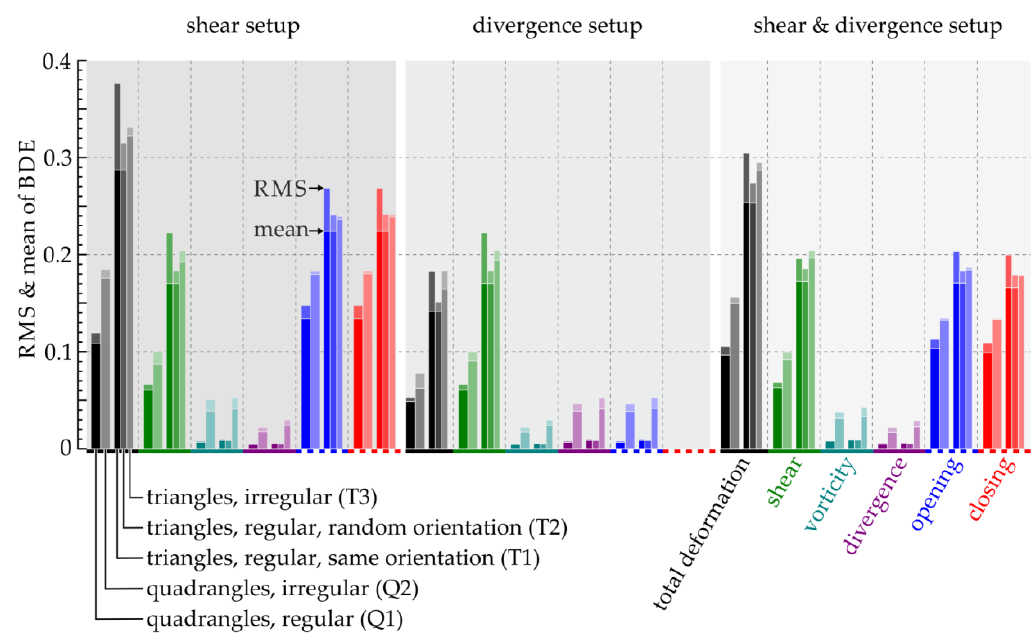
Figure 7. The RMS and mean of BDE for all deformation parameters and grid layouts, integrated over all rotation angles (Equations (17) and (18)).